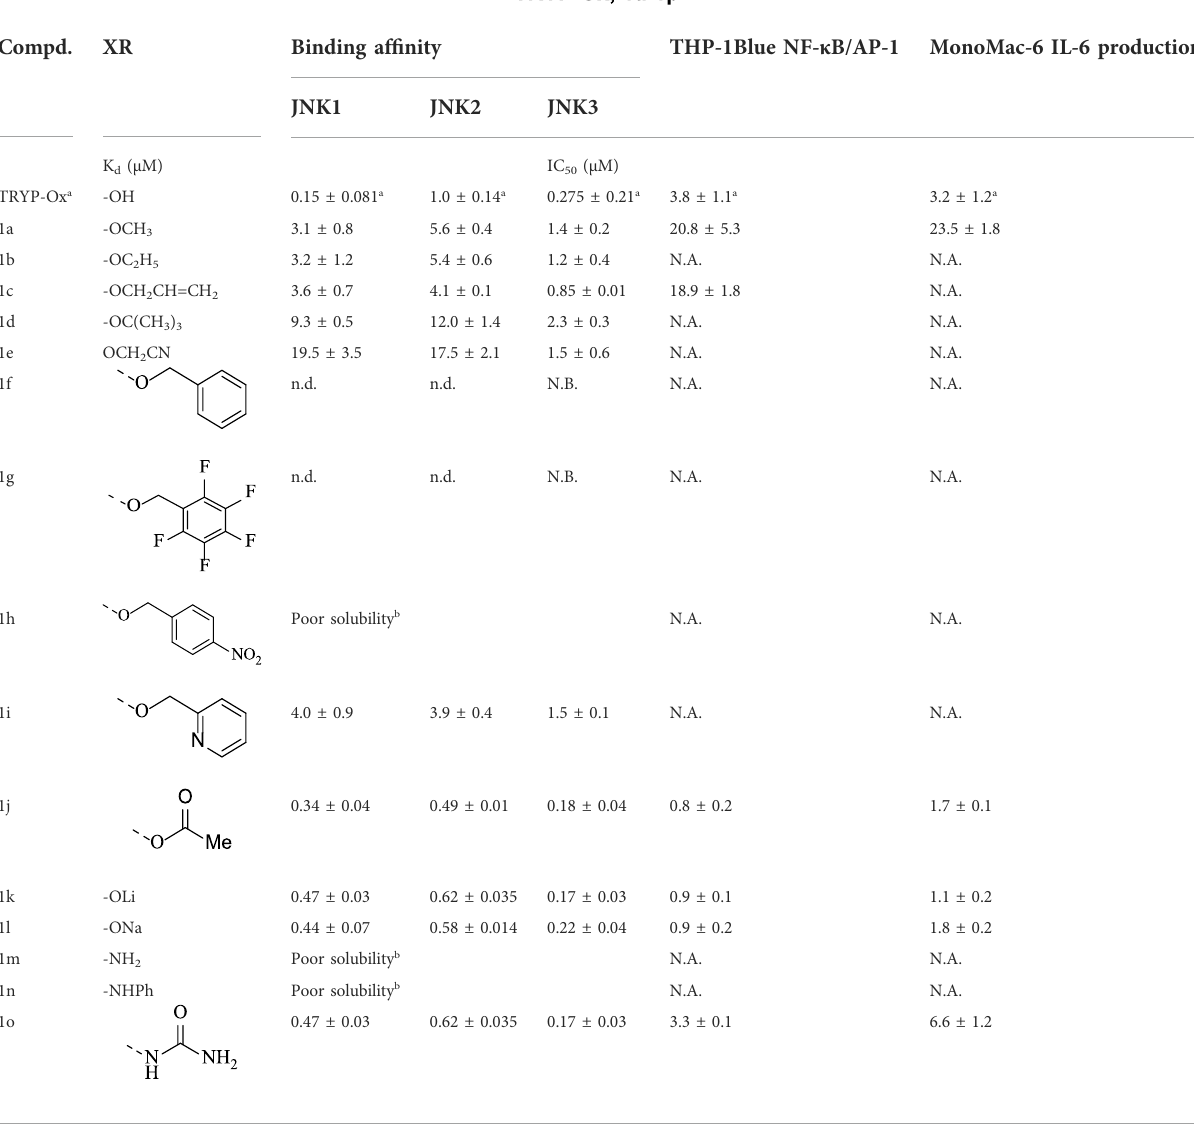
TABLE1Bindingaf fi nity(K d )ofcompounds1a-oandtheirinhibitoryeffectonLPS-inducedNF- κ B/AP-1transcriptionalactivityinTHP-1Bluecellsand IL-6 production in MonoMac-6 cells.